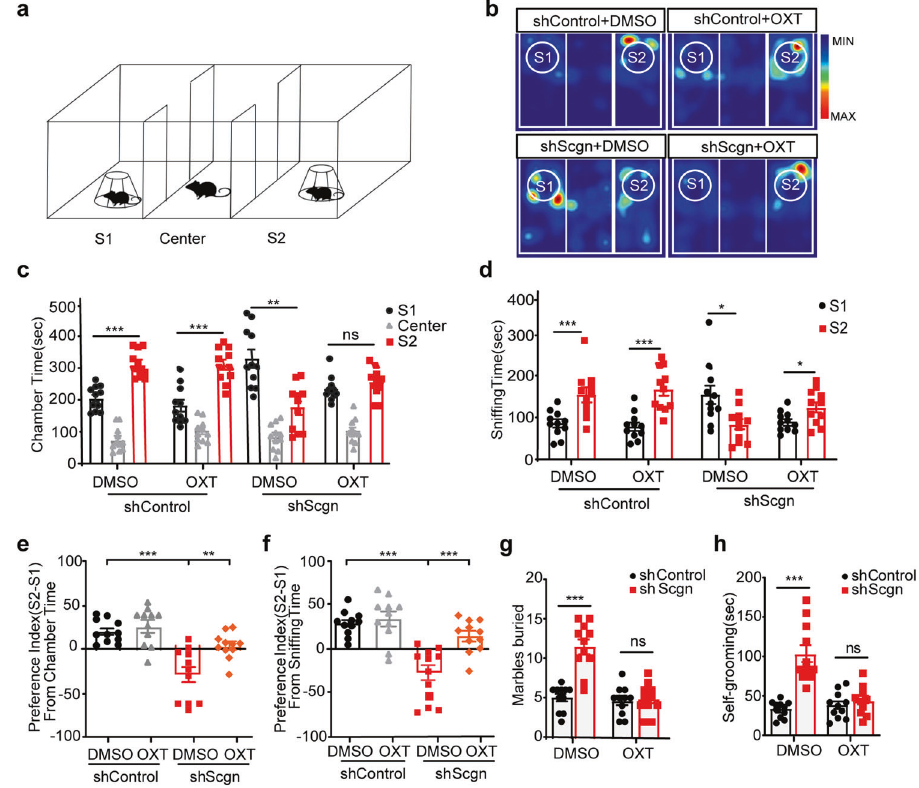
Fig. 7 Oxytocin treatment increases social novelty and decreases repetitive behaviors in SCGN-de fi ciency mice. a Schematic of social novelty recognition (three-chamber) test. Time spent interacting with S1(a familiar mouse) or S2 (a novel mouse) is shown for each genotype when injected with Control-shRNA EGFP and Scgn-shRNA EGFP AAV virus in PVN. b Representative heatmaps showing the duration and location of the shControl and shScgn mice during the 10 min social novelty recognition test. Warmer colors (red) indicate a greater amount of time spent exploring by the mice. shControl: PVN Control-shRNA injection mouse. shScgn: PVN Scgn-shRNA injection mouse. DMSO: 0.1% DMSO administration. OXT: 1 mg/kg Oxytocin administration. S1: a familiar mouse. S2: a novel mouse. c Bar chart showing chamber times spending interacted with S1 or a novel mouse S2 of shControl and shScgn mouse. S1: a familiar mouse. center: center region in chamber. S2: a novel mouse. shScgn: PVN Scgn-shRNA injection mouse. DMSO: 0.1% DMSO administration. OXT: 1 mg/kg Oxytocin administration. S1: a